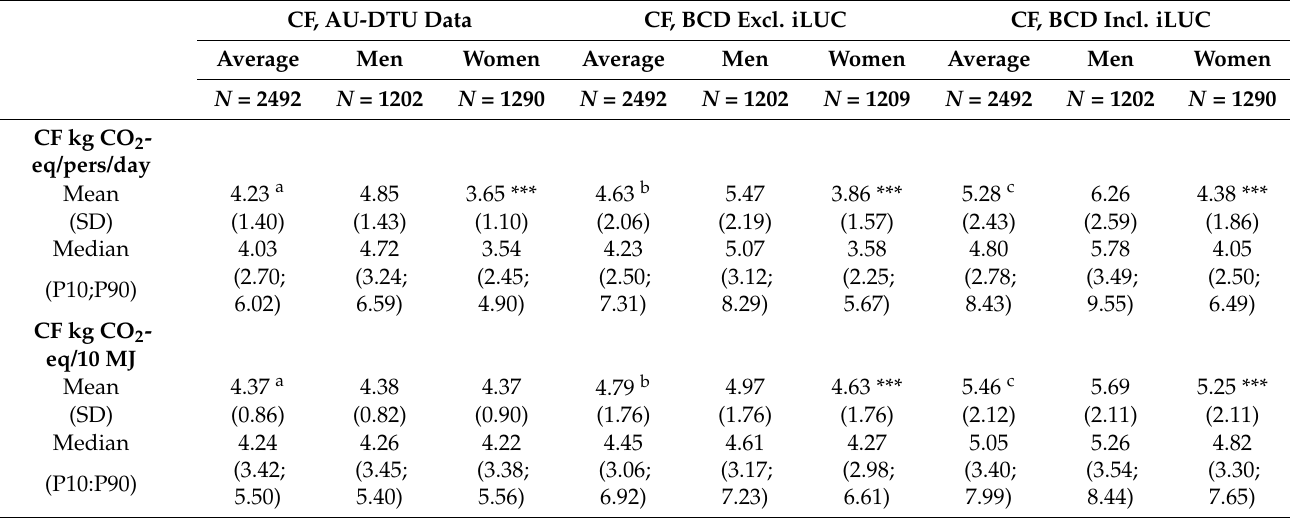
Table 1. Total carbon footprint (CF) of the current diet among adults (18–64 years), per person per day and per 10 MJ, respectively #, calculated using three different CF data sets at the retail gate. CF, AU-DTU Data CF, BCD Excl.